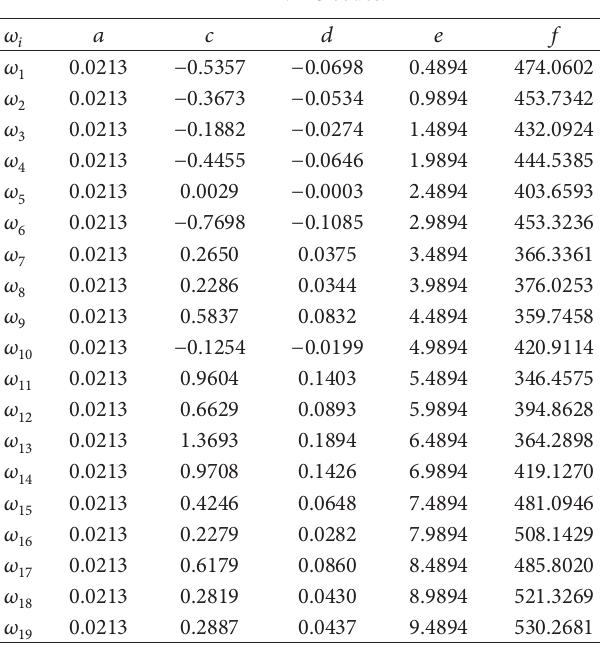
Table 2: IFS codes.